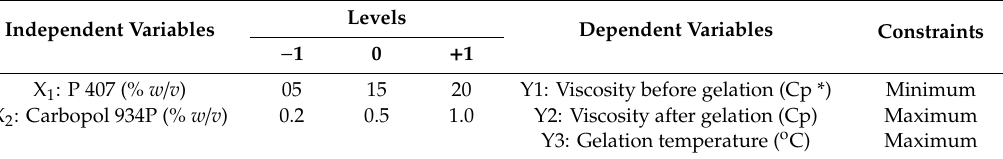
Table 2. Formulation parameters for RO-EA-NTS in situ gel. Independent